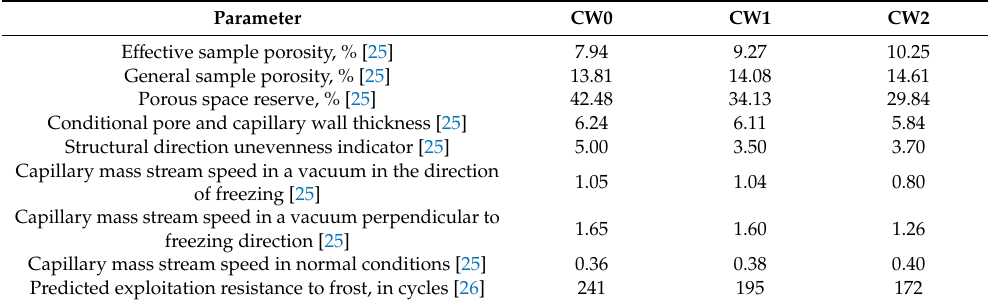
Table 5. Structural characteristics and predicted exploitation frost resistance of the